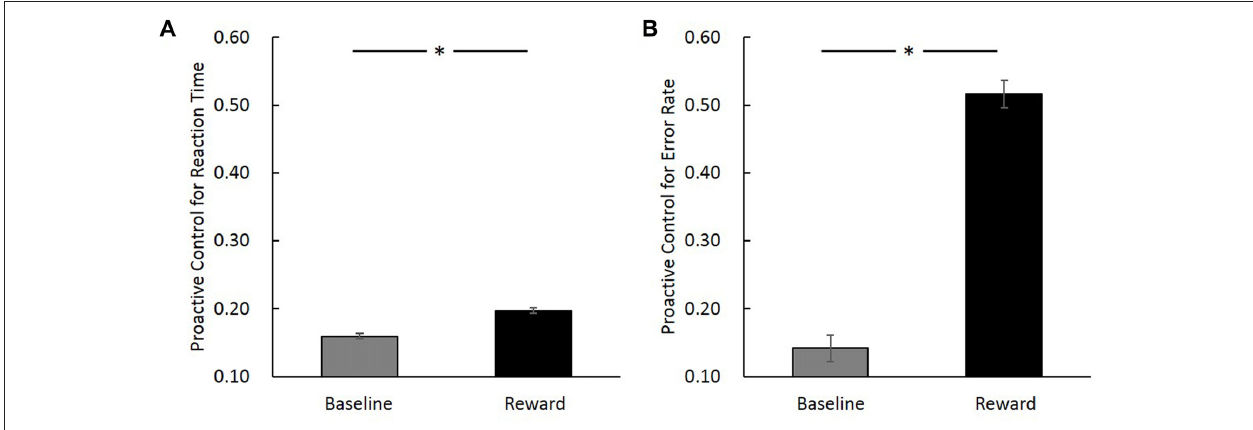
FIGURE 3 | Proactive control index ([AY − BX]/[AY + BX]) in baseline and reward block (reward trials in the incentive block) for reaction time (RT; A ) and error rate (B) . The horizontal axis denotes different conditions (baseline vs. reward) and the vertical axis represents the magnitude of proactive control (error bars denote standard errors). ∗ Indicates p <